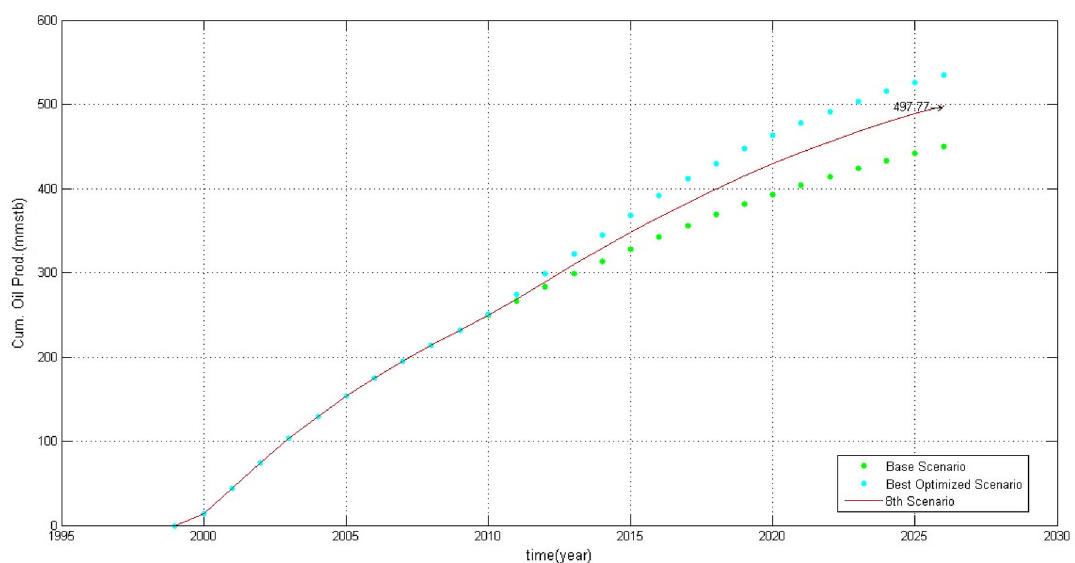
Fig. 16 Cumulative oil production of eighth